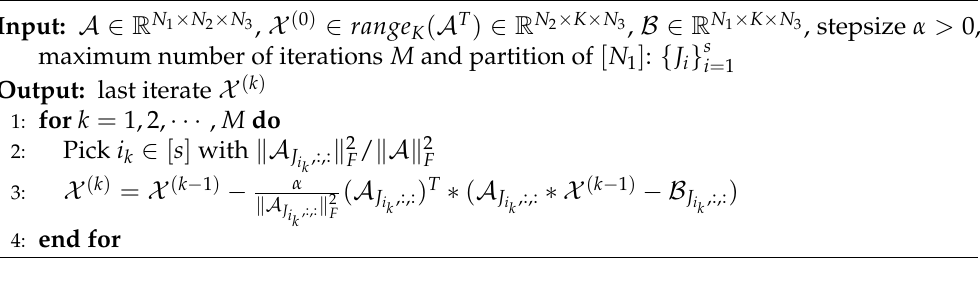
Algorithm 3 Tensor randomized average Kaczmarz (TRAK)